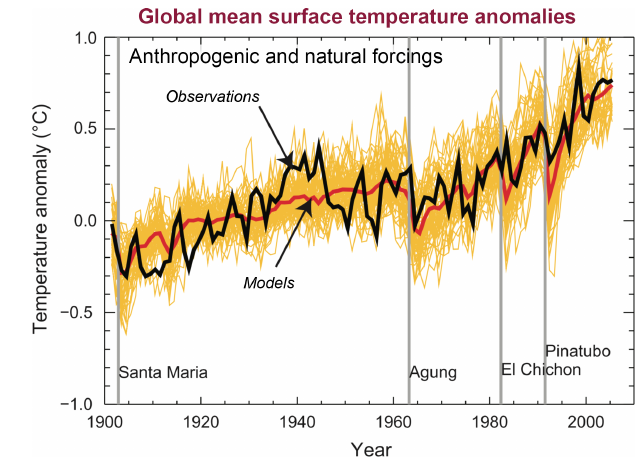
Figure 3. Figure TS.23 taken from the Technical Summary of WG1 in the IPCC Fourth Assessment Report, showing the multi-model mean’s decreased variability (red) relative to individual models (yel- low) and observations (black), as well as the effect of volcanic forc- ing on ensemble